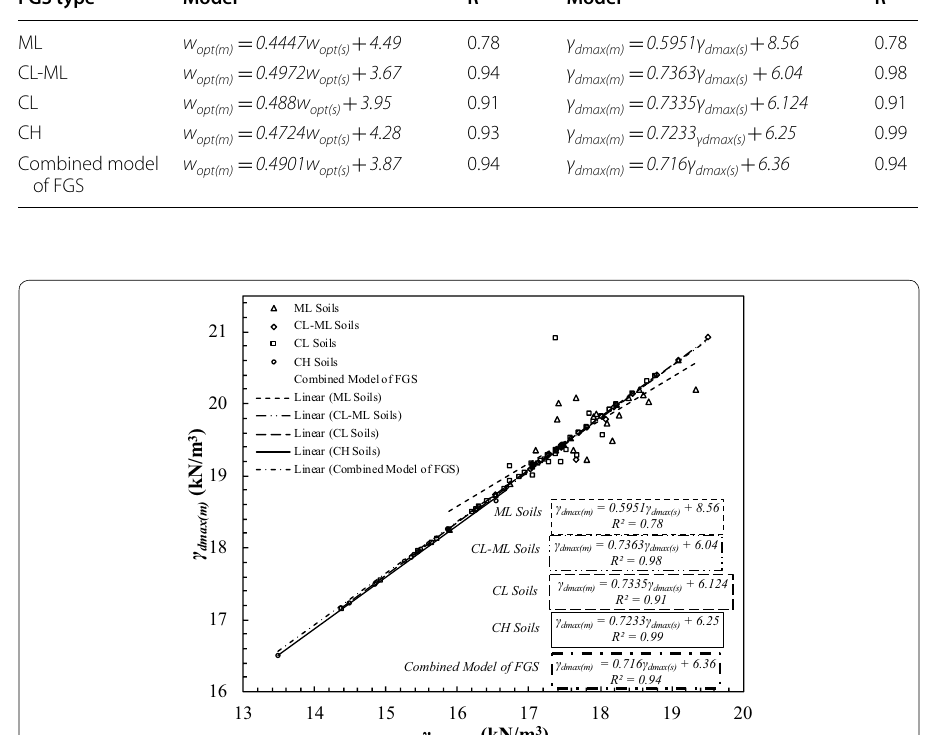
Fig. 8 Correlations of modified maximum dry unit weight ( γ dmax(m) ) with standard maximum dry unit weight (